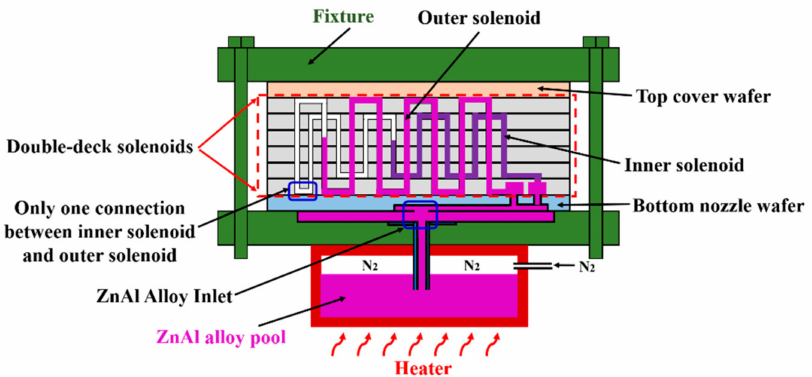
Figure 4. Schematic of the molten metal casting setup. At the moment the double-deck solenoid has been partly filled. The details of the casting process, including the following cooling, solidification and the casted wafer demolding from the top-cover and the bottom nozzle wafers, can be read in reference [28].